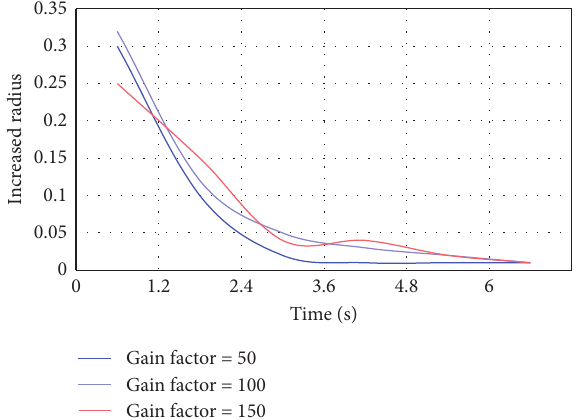
Figure 5: Spectral radius of closed-loop